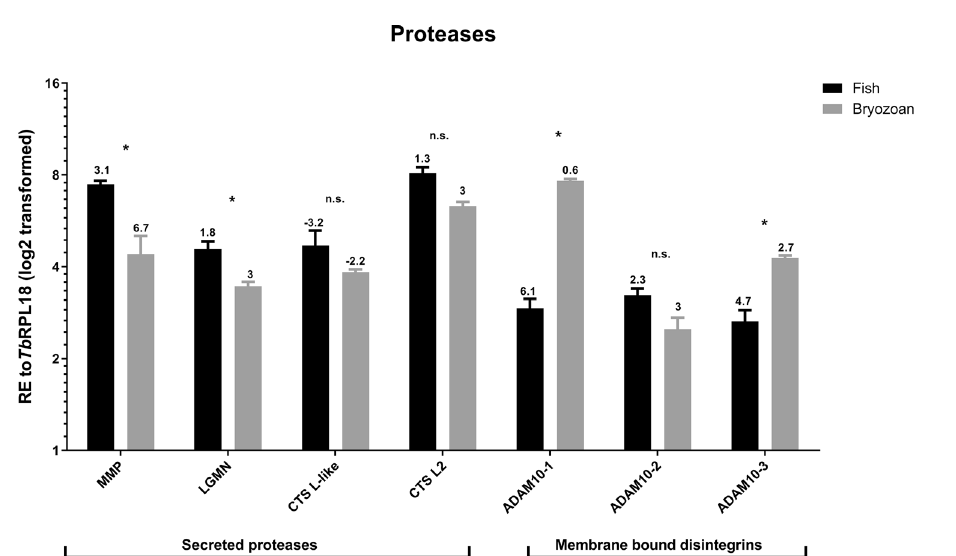
Figure 5. Average relative gene expression in infected bryozoan and infected fish kidney tissues of representative T. bryosalmonae proteases. All gene values were normalized to Tb RPL18. Δ Cq values, stated above each bar, represent the expression level of genes of interest relative to Tb RPL18 in each infected host with values > 1 indicating lower expression and values < 1 indicating higher expression relative to Tb RPL18. * P < 0.05. Black bars = infected fish, grey bars = infected bryozoan. Gene abbreviations: matrix metalloprotease 13 (MMP), Legumain (LGMN), Cathepsin L-like (CTLS-like), Cathepsin L2 (CTS L2) and Disintegrin and metalloproteinase domain-containing protein